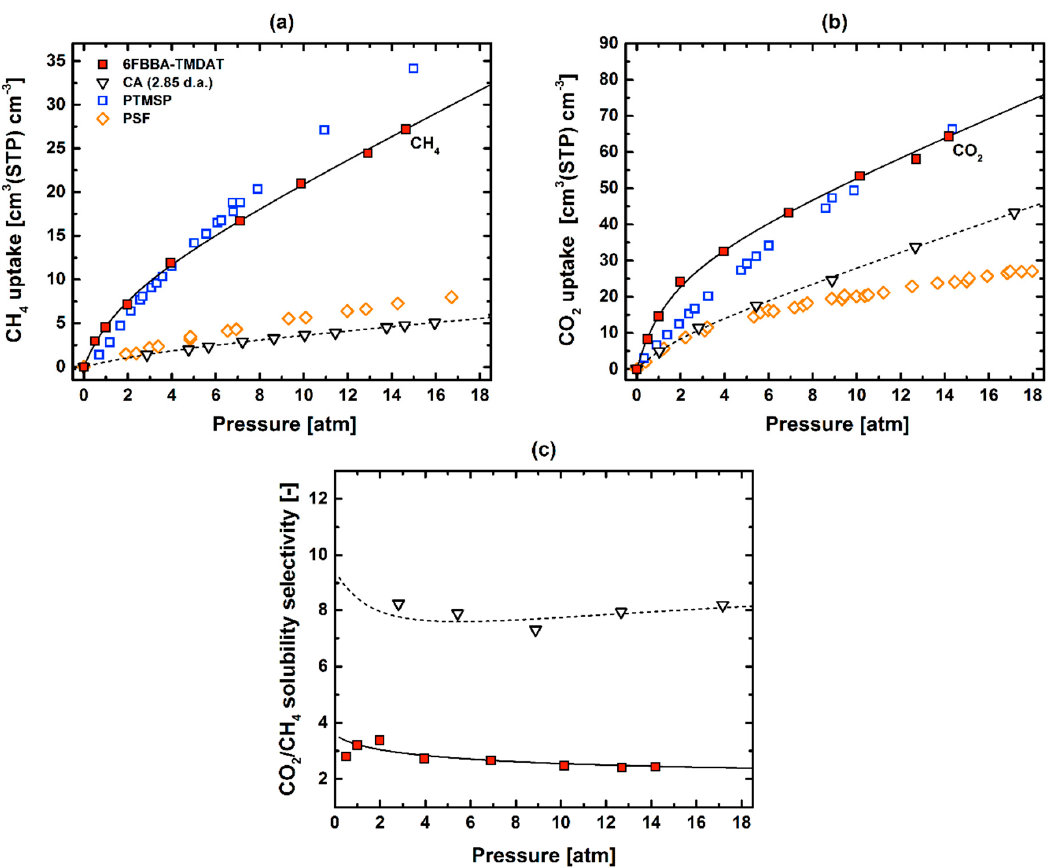
Figure 8. ( a ) CH 4 and ( b ) CO 2 pure-gas sorption isotherms vs. gas pressure. ( c ) CO 2 /CH 4 pure-gas solubility selectivity of 6FBBA-TMDAT polyamide (red squares) and CA (black triangles) vs. gas pressure. Gas sorption data of polysulfone (PSF—orange diamonds) [62], poly[1 -trimethylsilyl-1-propyne] (PTMSP—blue squares) [60], and cellulose acetate (CA) [61] were digitalized from the literature. A dual-mode sorption model analysis [63] (not discussed) allowed to draw all prediction curves.